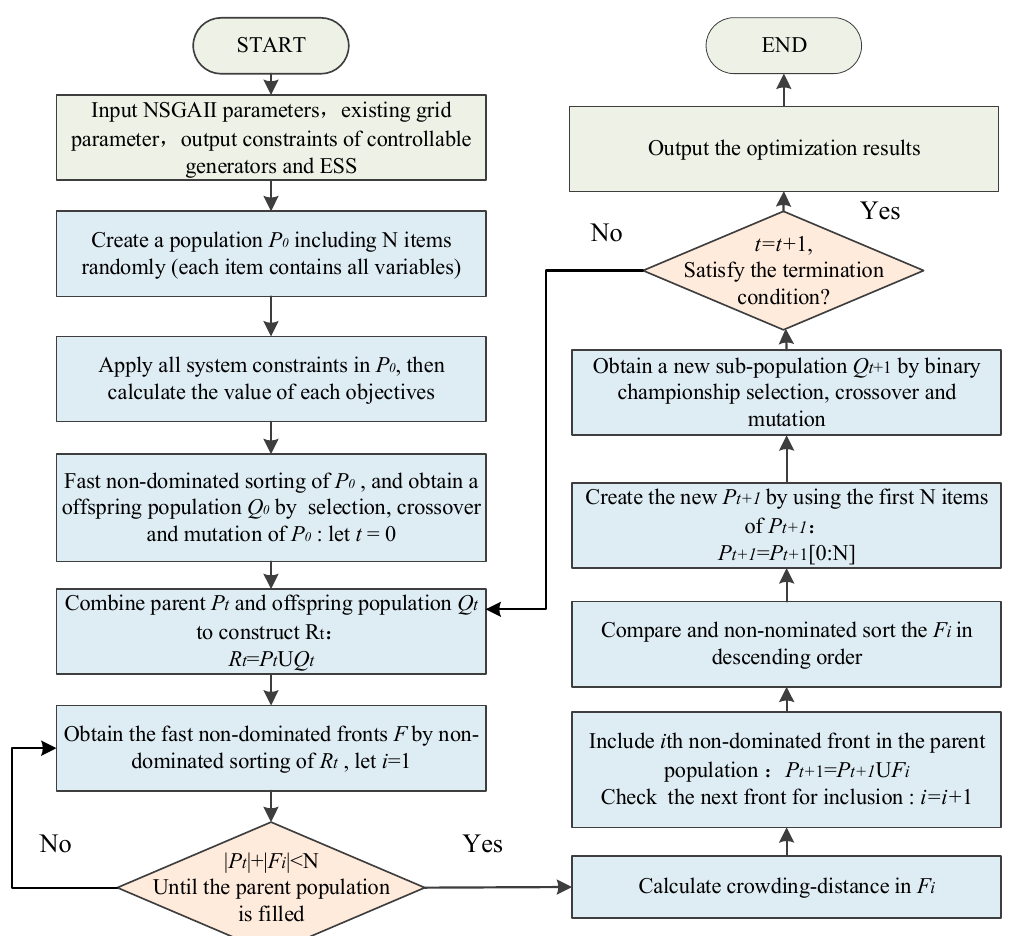
Figure 3. Processing flow of non-dominated sorting genetic algorithm II (NSGA-II).